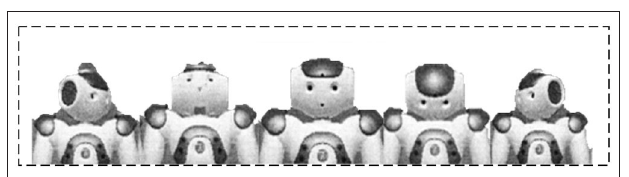
FIGURE 8 | Basic dance elements imitated on upper body L 2